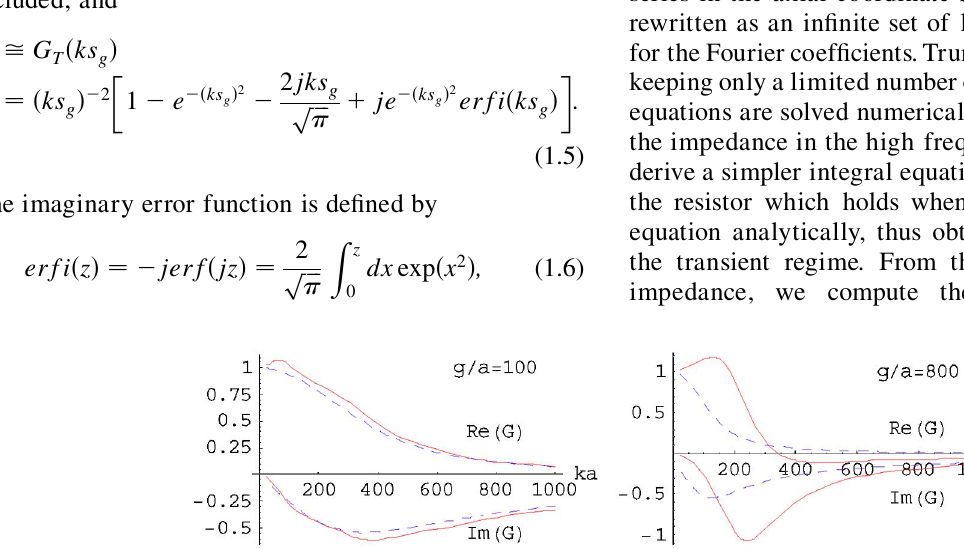
[Eq. (1.5)] are seen to be in agreement with the solid T